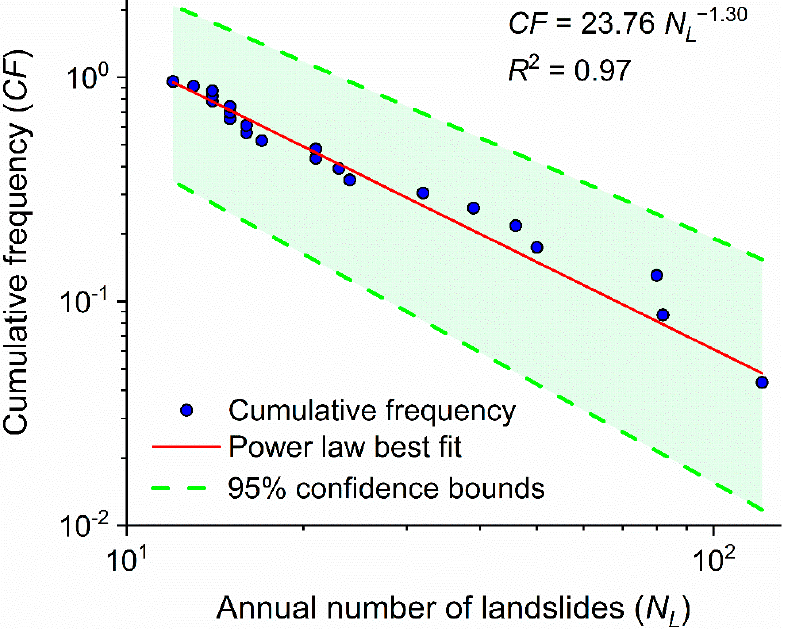
Figure 4. Cumulative frequency of the annual landslide number.